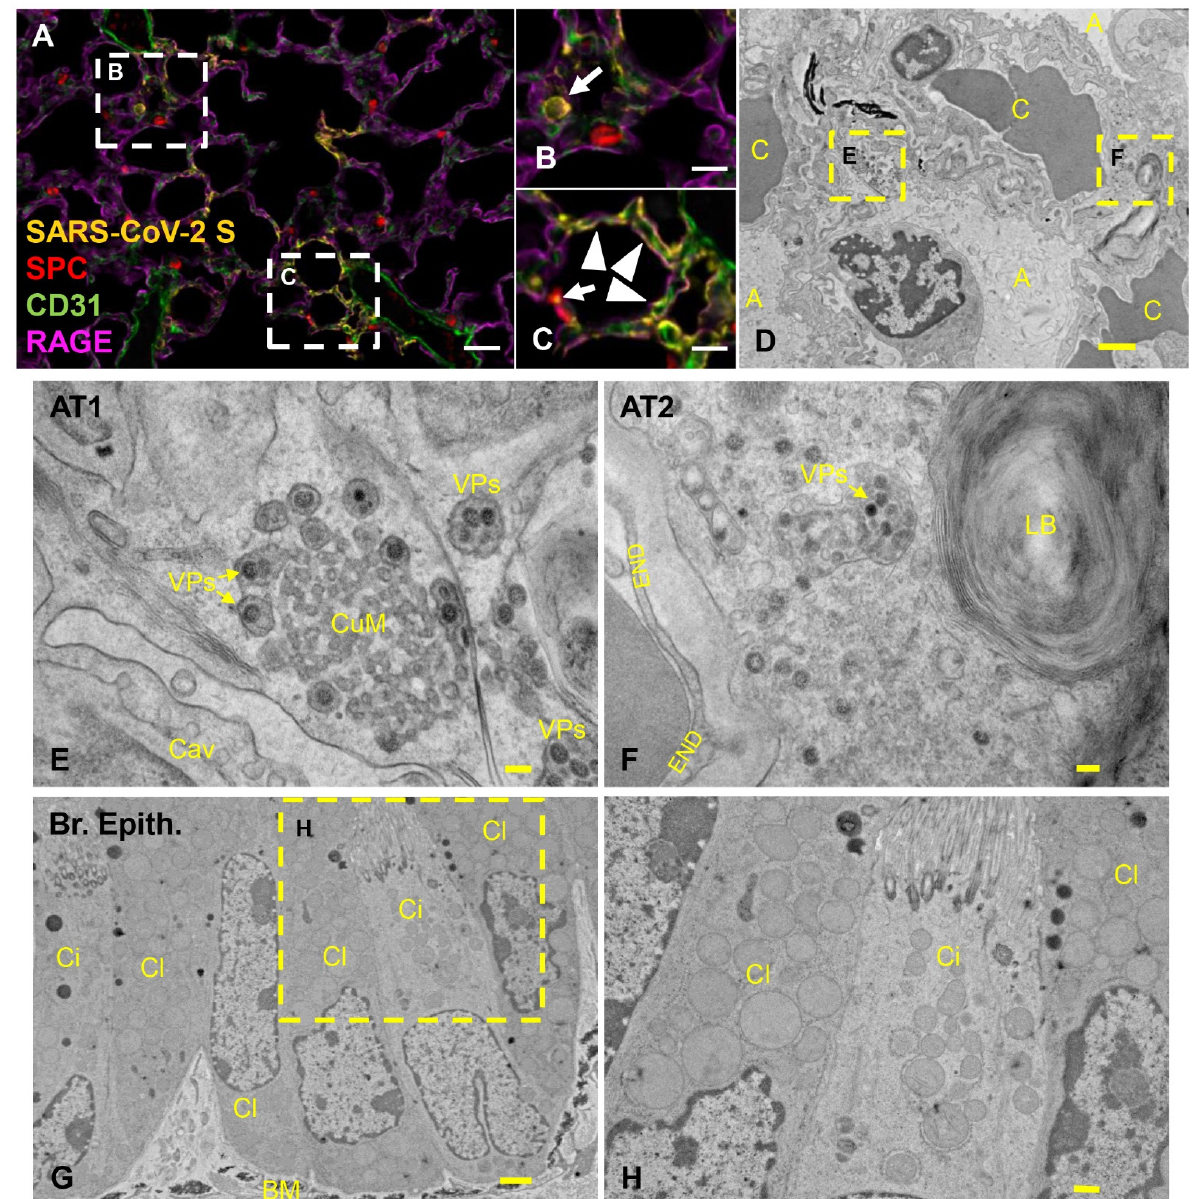
Figure 4. SARS-CoV-2 tropism following intranasal inoculation in K18-hACE2. ( A – C ) At 4 dpi, SARS-CoV-2 (yellow) tropism for RAGE+ alveolar type 1 (AT1, magenta) and scattered SPC+ alveolar type 2 (AT2, red) pneumocytes ( B , C , arrowheads, and arrows, respectively) but not for CD31+ endothelial cells. ( B , C ) represent higher magnification images of the white hashed boxes from ( A ), respectively. At 6 dpi-terminal disease ( D – F ), interpretation of transmission electron microscopy images illustrated virus particles (VPs) bound by vesicles in AT1 ( E ) and AT2 ( F ) cells. AT1 contained abundant caveolae. Another unique feature observed in AT1 cells was the presence of cubic membranes (CuM). AT2 pneumocytes were characterized by presence of lamellar bodies (LB). ( E , F ) represent higher magnification images of the yellow hashed boxes from ( D ). ( G , H ) Viral particles or viral induced membrane alterations were not identified in ciliated or non-ciliated club (Cl) bronchiolar epithelial cells. ( H ) represents a higher magnification of the yellow hashed box in ( G ). Multiplex fluorescent IHC, 100 × ( A ; bar = 100 µ m) and 200 × ( B , C ; bar = 50 µ m) total magnification. TEM, bar = 2 µ m ( D ), 100 nm ( E – H ), and 3 µ m ( G ). A, alveolar lumen; BM, basement membrane; C, capillary; Cav, caveolae; Ci, ciliated epithelium; Cl, club epithelium; CuM, cubic membranes; DMVs, double-membrane vesicles; END, endothelium; VPs, viral